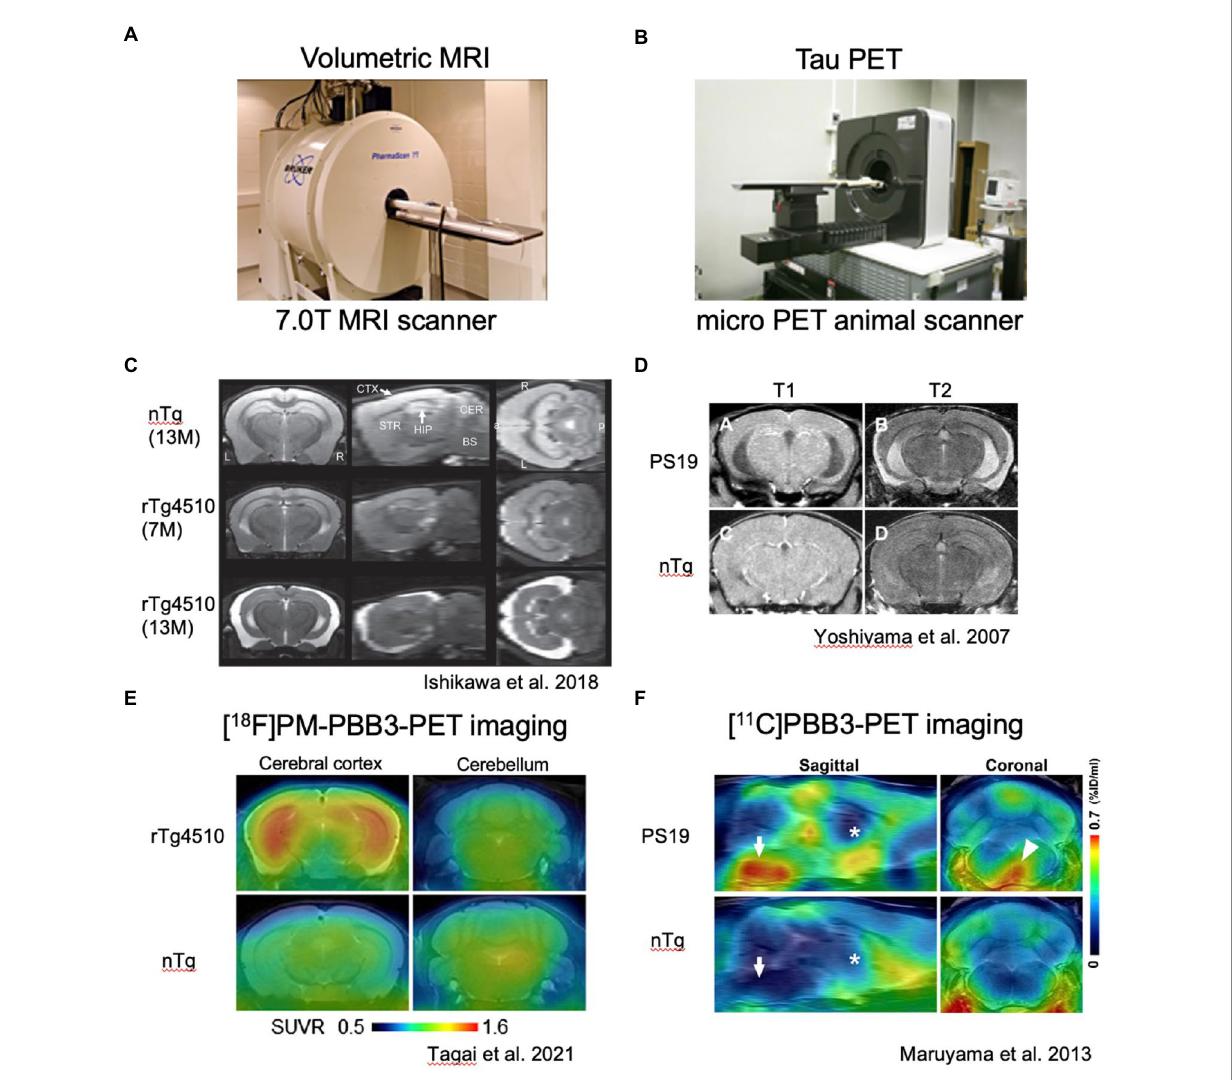
FIGURE 1 In vivo imaging analyses of rTg4510 and PS19 mouse brain pathologies. (A) Representative photograph of small animal MRI scanner. (B) Representative photograph of micro PET scanner. C and D. Volumetric MR images of rTg4510 mouse brains (C) with coronal, sagittal and horizontal slices and PS19 mouse brains (D) with coronal slices. E and F. Tau PET images of rTg4510 (E) and PS19 (F) mice. E. Coronal brain images of 9-month-old rTg4510 (top) and nTg (bottom) mice acquired by averaging dynamic PET data at 40–60 min after [ 18 F]PM-PBB3 injections. (F) Sagittal and coronal PET images generated by averaging dynamic scans at 60–90 min after [ 11 C]PBB3